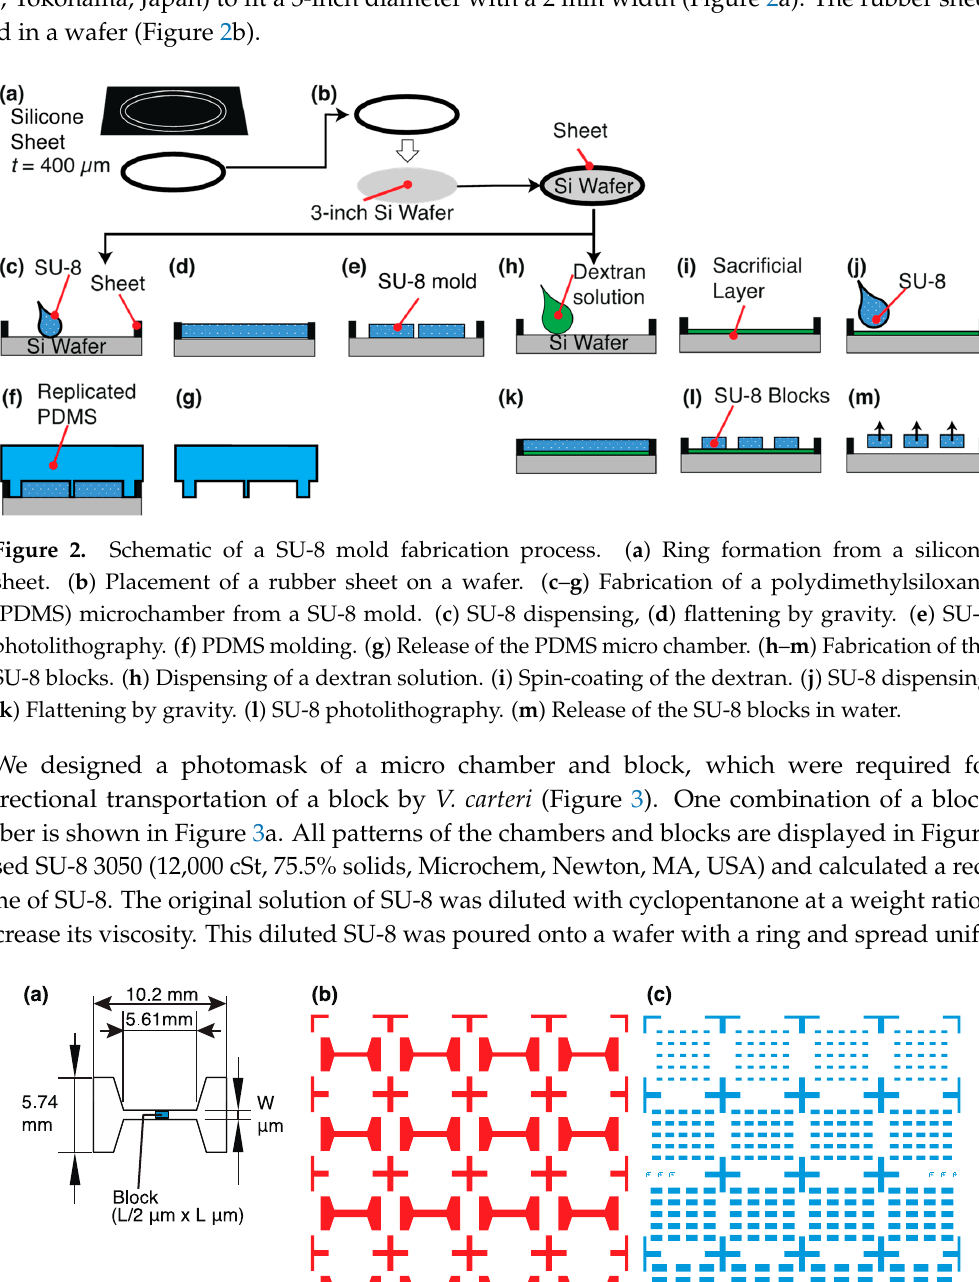
Figure 3. Design of a block and chamber for the actuation experiment by Volvox . ( a ) Dimensional drawing of a single block integrated in a chamber. Photomask patterns of ( b ) chambers and ( c ) blocks.